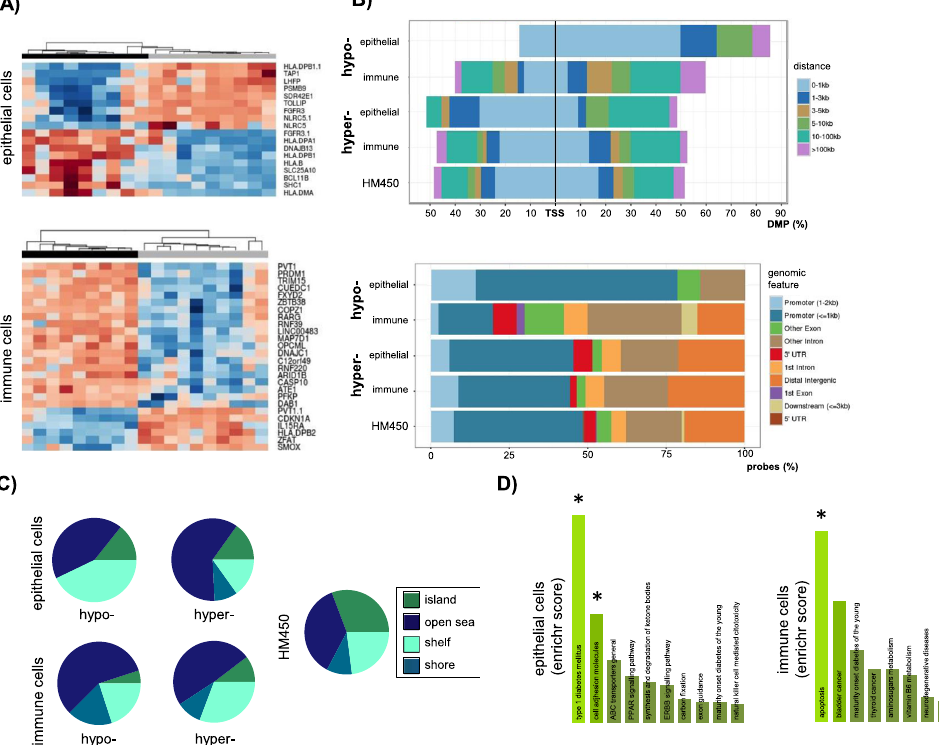
Figure 2. General DMP analysis for CD status in each cell type. ( A ) Heatmap showing active CD (black) and controls (grey) in columns and the genes closest to the most differentially methylated DMPs in rows, with the blue-red color scale representing the hypo- to hypermethylation trend. ( B , C ) Distribution of DMPs, relative to transcription start sites, genomic features and CpG content and characterization, respectively. ( D ) KEGG pathway analysis of the DMPs. All analyses were performed with FDR < 0.05 and delta-beta > 10% cuttoffs, except for the heatmap (delta-beta >